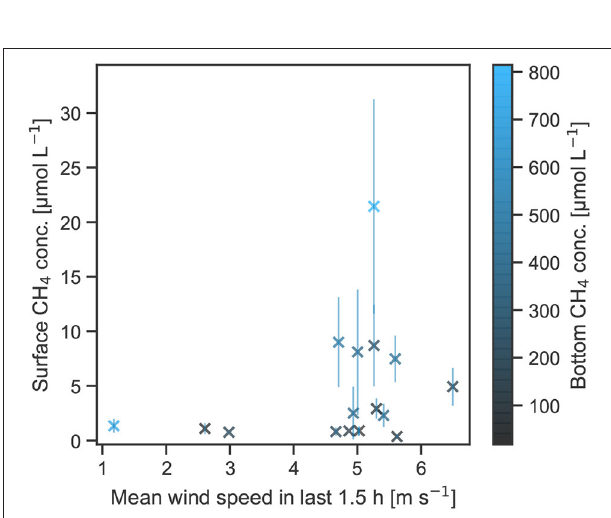
FIGURE 5 | Surface methane concentrations of the ice-wedge ponds in relation to mean wind speed in the last 1.5 h and methane bottom